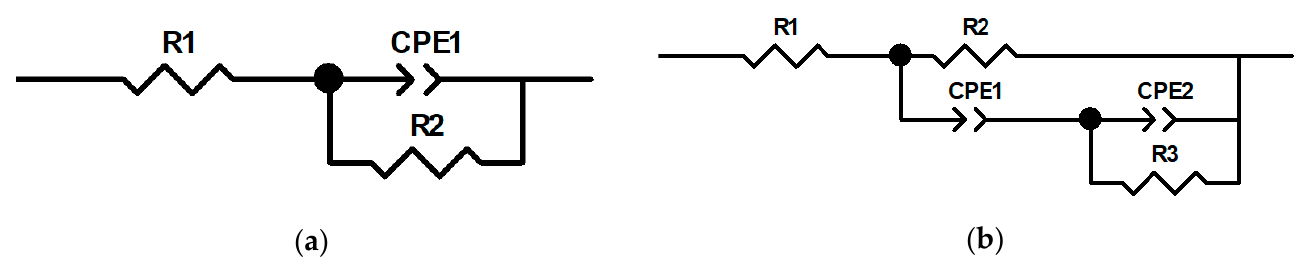
Figure 10. Nyquist plots of the CP-Ti samples before and after anodic PENC at 900 °C and subse- quent PEP in a solution of ammonium fluoride (4%) at 300 V for different time.